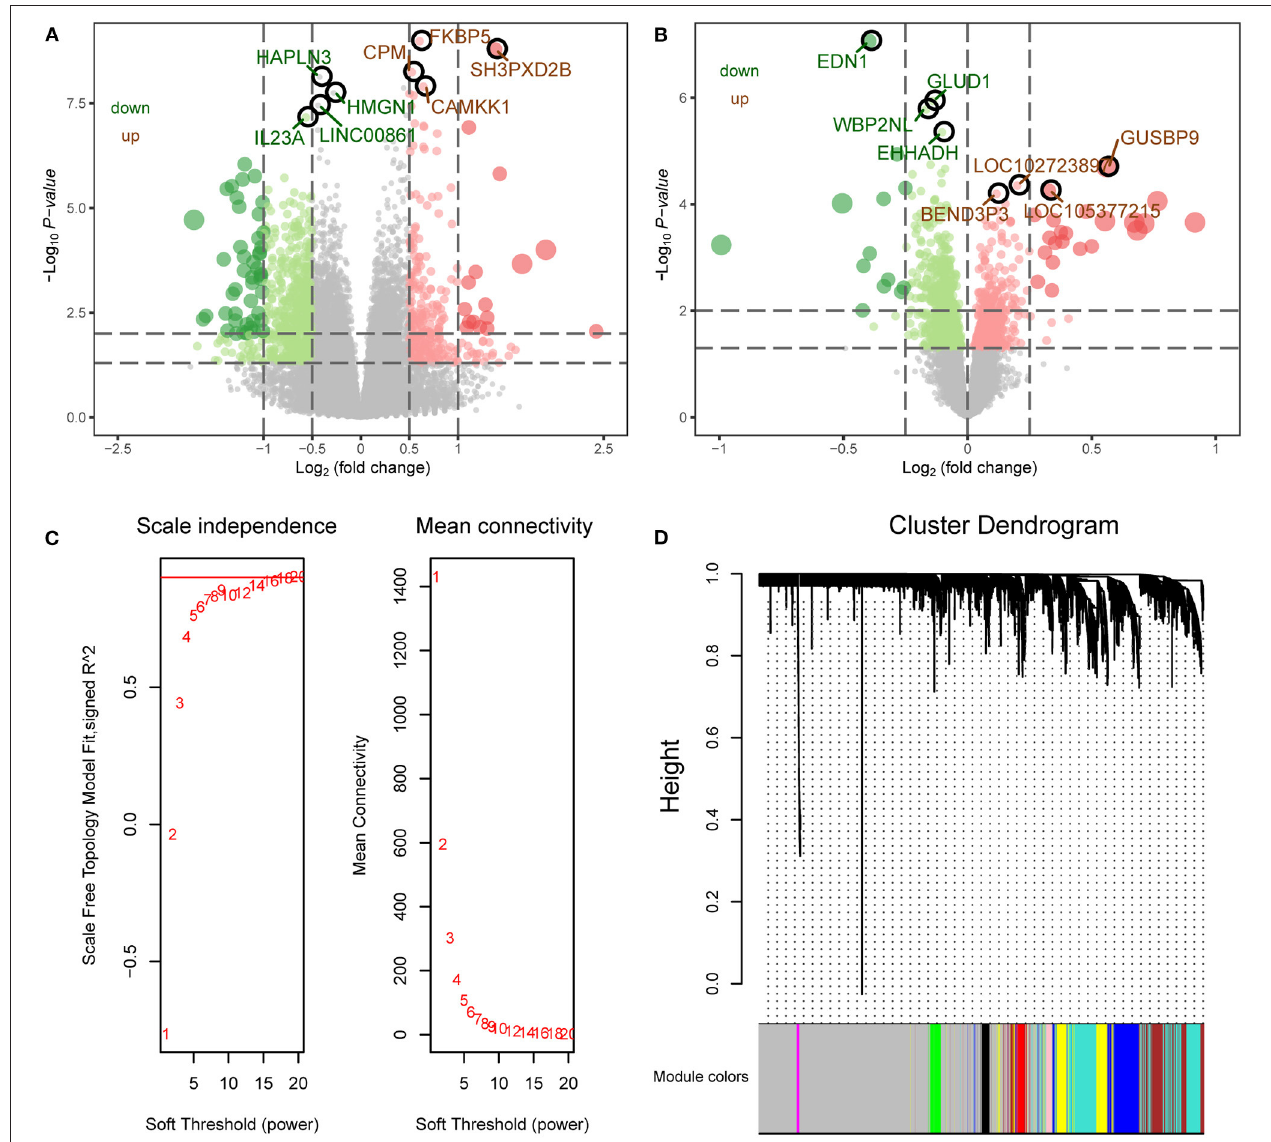
FIGURE 2 | WGCNA network of differentially expressed genes. (A) The differentially expressed genes between TBI and control in GSE89866 data. Red nodes were significantly up-regulated genes, and green nodes were significantly down-regulated genes. (B) The differentially expressed genes between TBI and control in GSE104687 data. Red nodes were significantly up-regulated genes and green nodes were significantly down-regulated genes. (C) Scale free fitting index analysis and average connectivity analysis of different soft threshold ( β ). The left image shows the scale-free fit index ( y -axis) as a function of the soft-thresholding power ( x -axis). The right image shows the average connectivity (degree, y -axis) as a function of the soft-thresholding power ( x -axis). (D) The coexpression modules were constructed by the amalgamation of differentially expressed genes in two groups. Different colors represent different